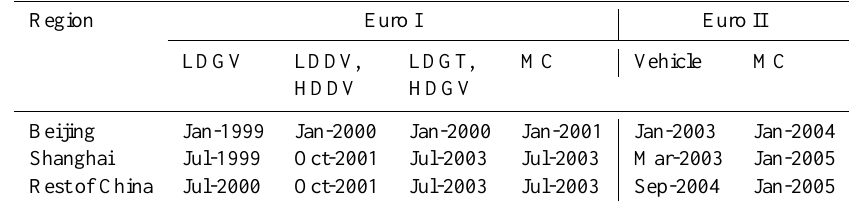
Table 8. Starting date of implementation of China’s Stage I and Stage II emission standards for vehicles. Region Euro I Euro II LDGV LDDV, LDGT, MC Vehicle MC HDDV HDGV